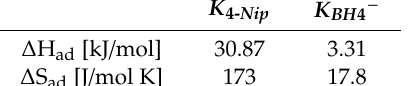
Table 4. Summary of thermodynamic parameters for the adsorption process of 4-Nip and BH 4 −